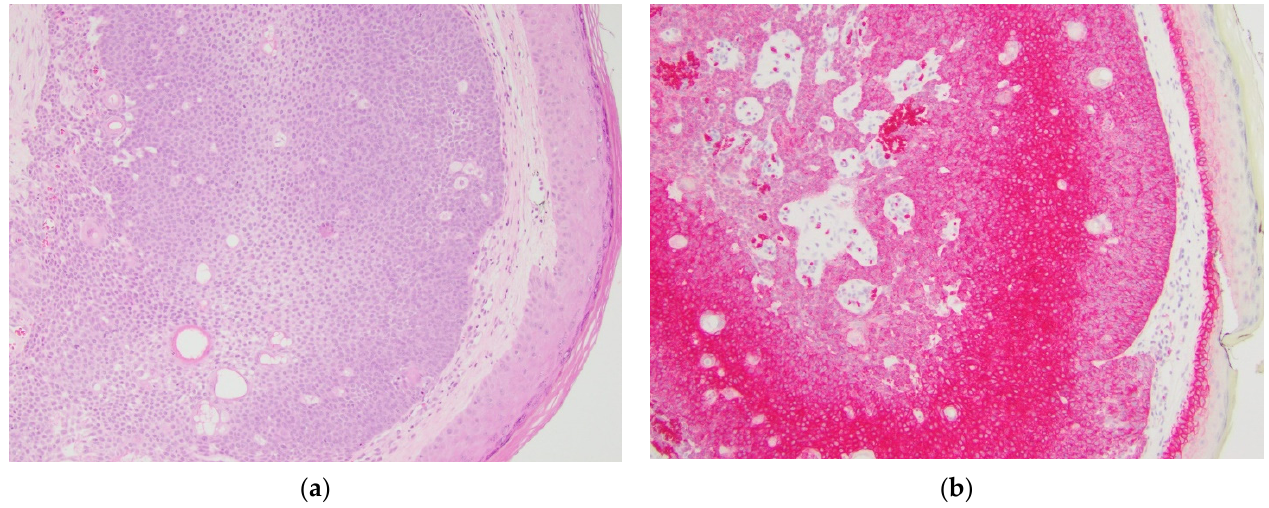
Figure 2. Sebaceoma, sample case. ( a ) Hematoxylin and eosin-stained section showing a well-circumscribed dermal tumor